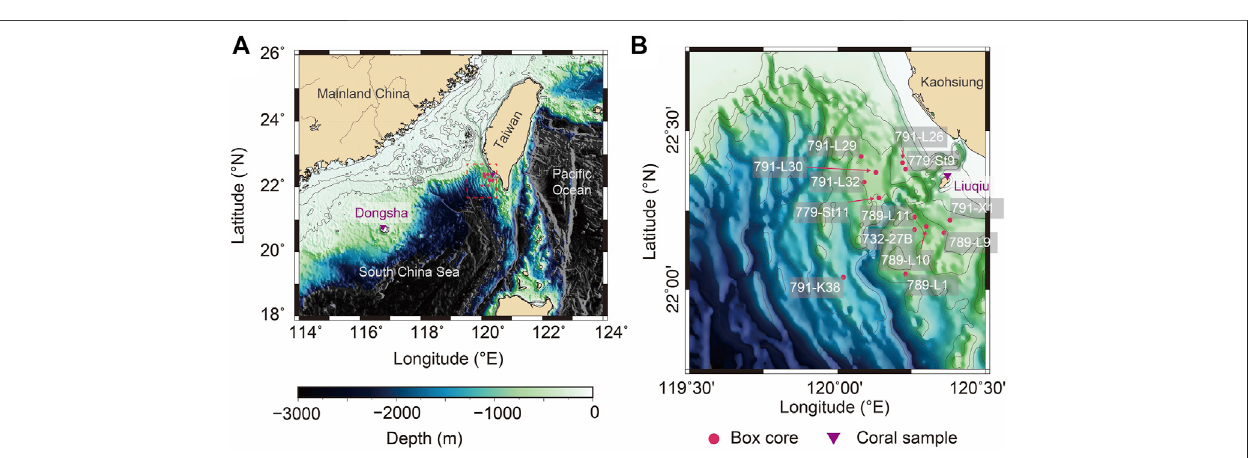
FIGURE 1 | (A) The location of Taiwan and Dongsha in the Western Paci fi c. Red circles represent the sampling locations of the box core, and purple triangles represent the sampling locations of the coralcore. (B) is the enlarged segment of (A) marked with the red dash square and shows the location and label of the collected box